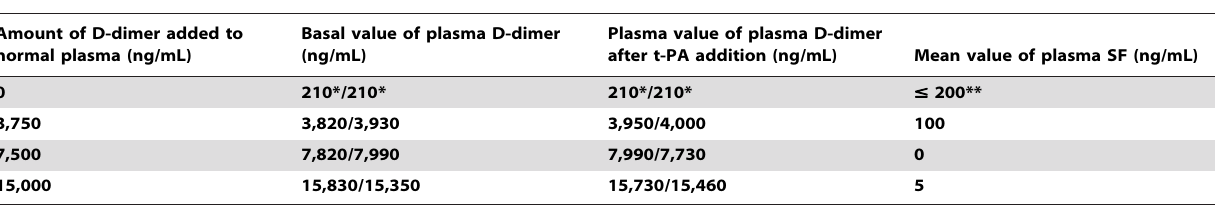
Table 1. Specificity of the test: Absence of interference by fibrin degradation products.